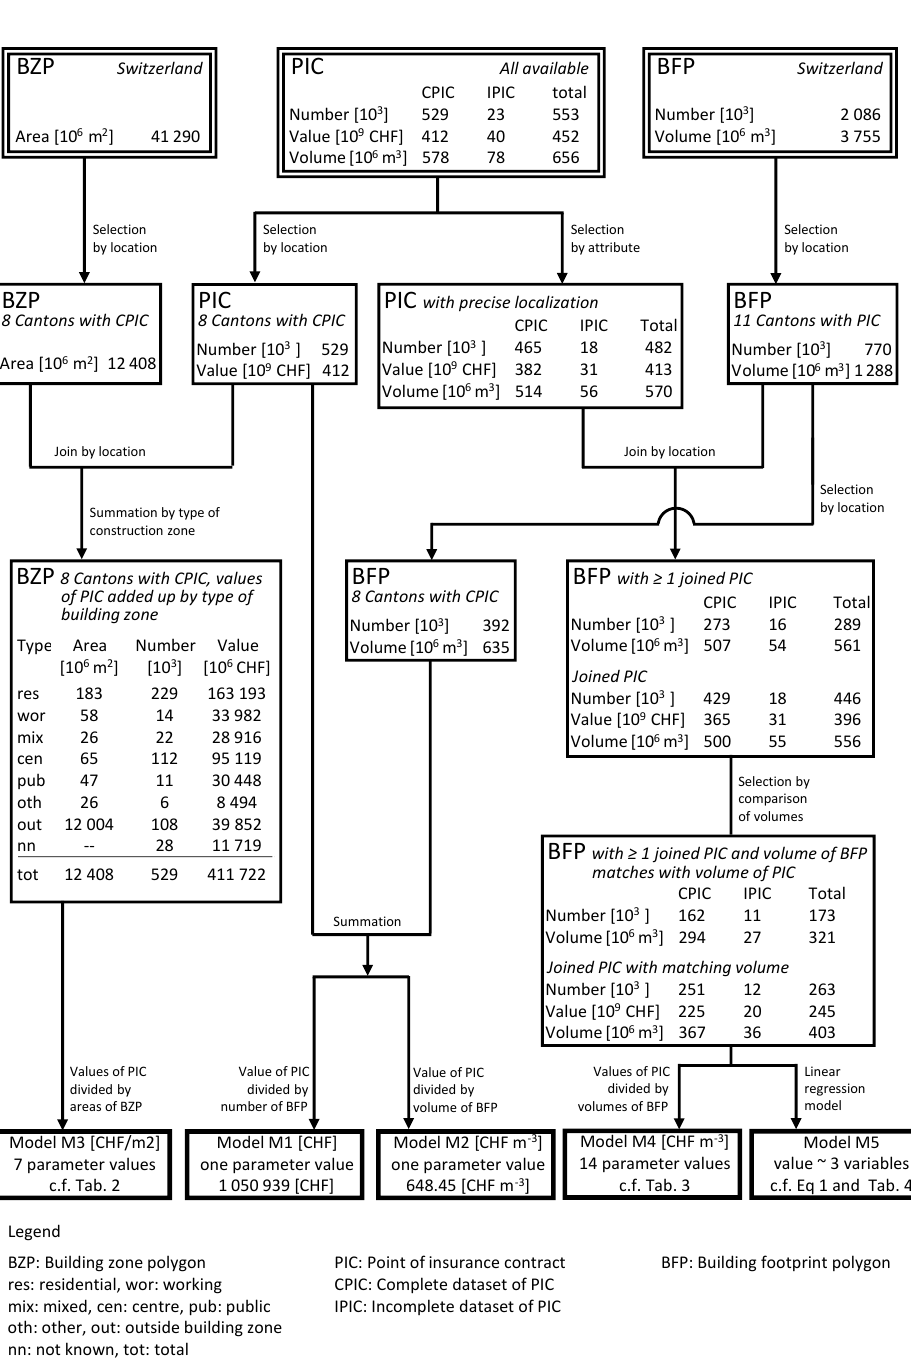
Figure 1. Workflow of the set-ups of the five investigated models for building value